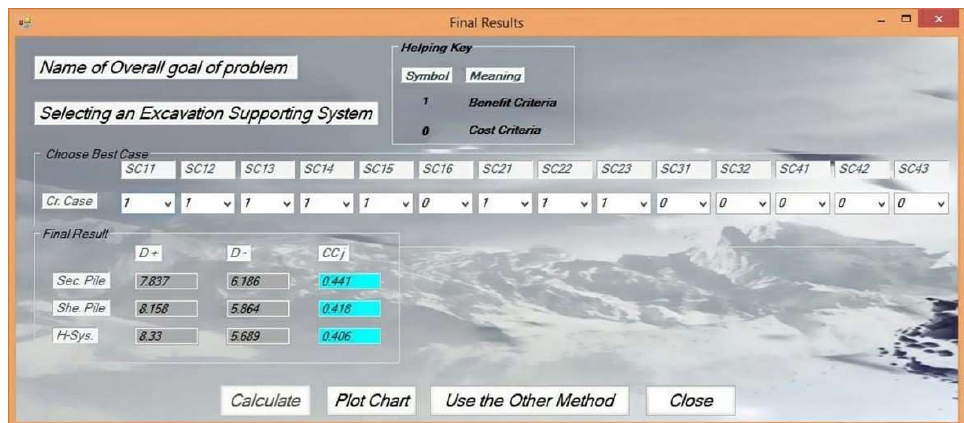
Figure 9. Identification of cost and benefit criteria, and final results.